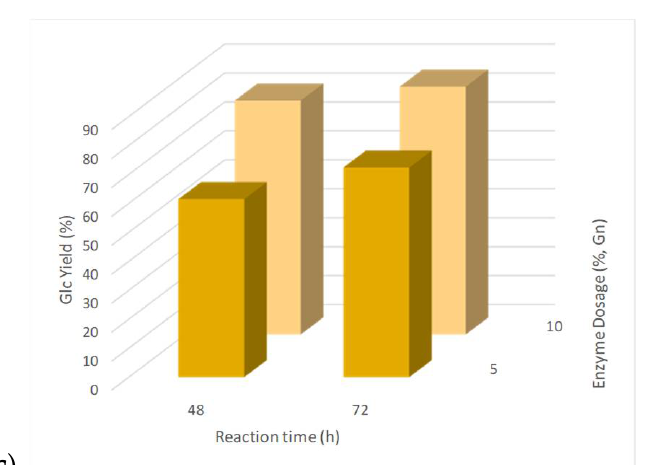
Figure 10. Effect of enzyme dosage and enzymatic reaction time on the enzymatic saccharification of wheat straw ethanol–water organosolv pulp obtained at 190 °C without ( a ) and with 50 mM acetic acid ( b ), or at 140 °C and with 50 mM sulphuric acid as catalyst ( c ).